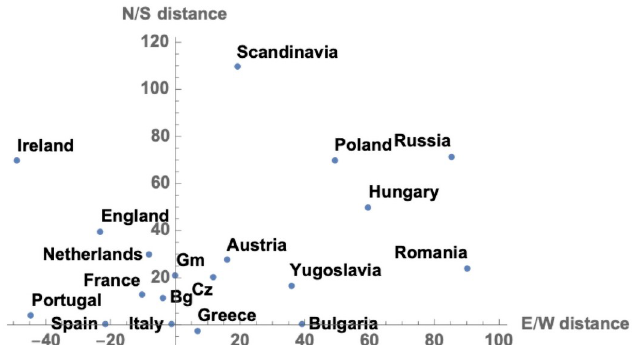
Fig 5. Ascribed distance and geography. The direction of each country relative to Italy is the actual geographic angular direction from Rome. The distance of each country from Italy is the distance ascribed by the model, in arbitrary units. Bg = Belgium, Gm = Germany, Cz = Czechoslovakia.